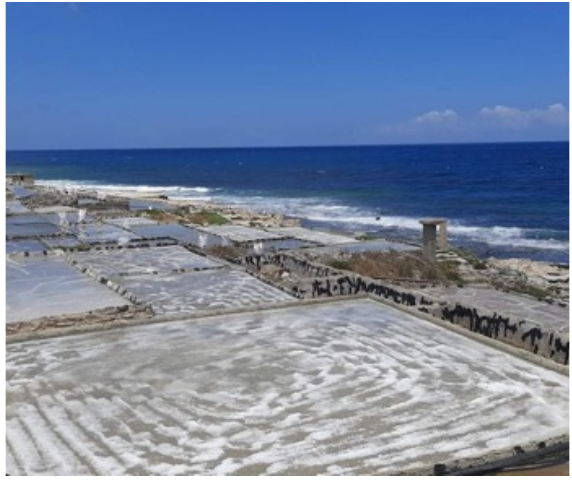
Figure 3. Anfeh’s coastal